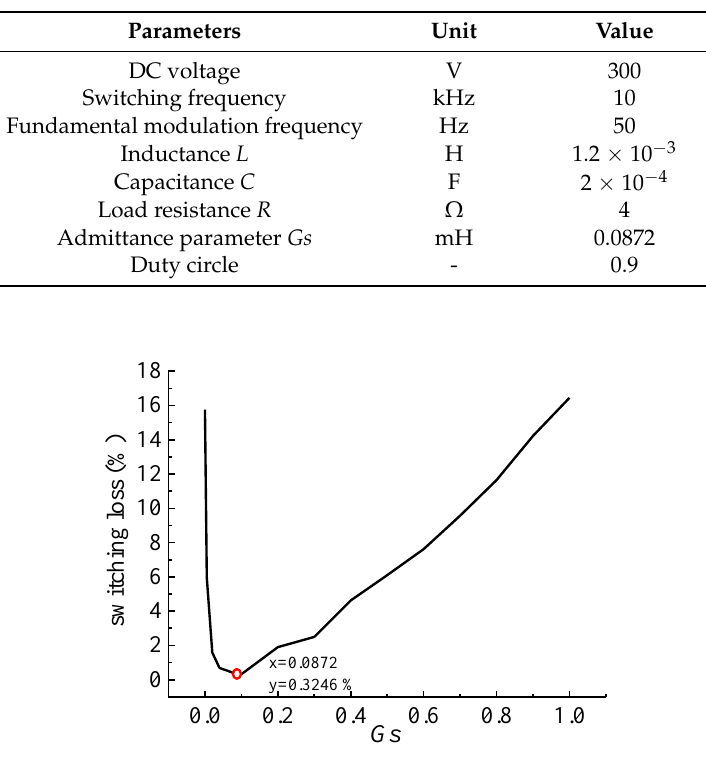
Figure 5. Switching loss trend with the switch admittance parameter ( Gs ).